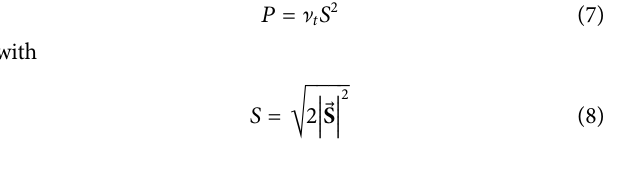
Frontiers in Environmental Science |